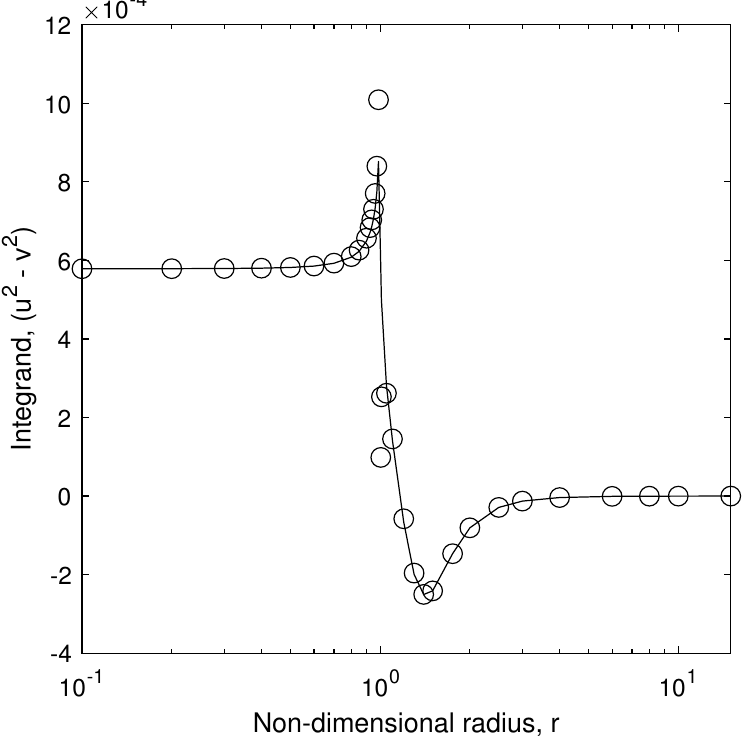
Figure 6. u 2 v 2 for p = 0.1 in Table 1. Circles show integrand using u and v , solid line shows integrand from u ( θ ) and v ( θ ) . Note that the x scale is − −